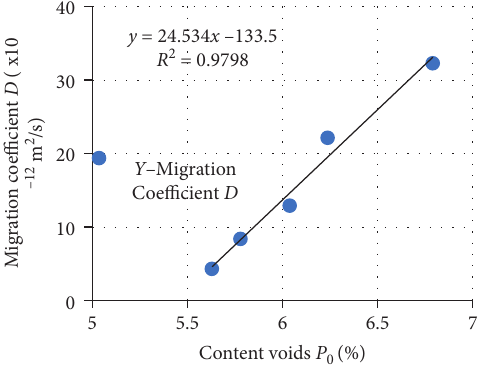
Figure 14: Relationship between P